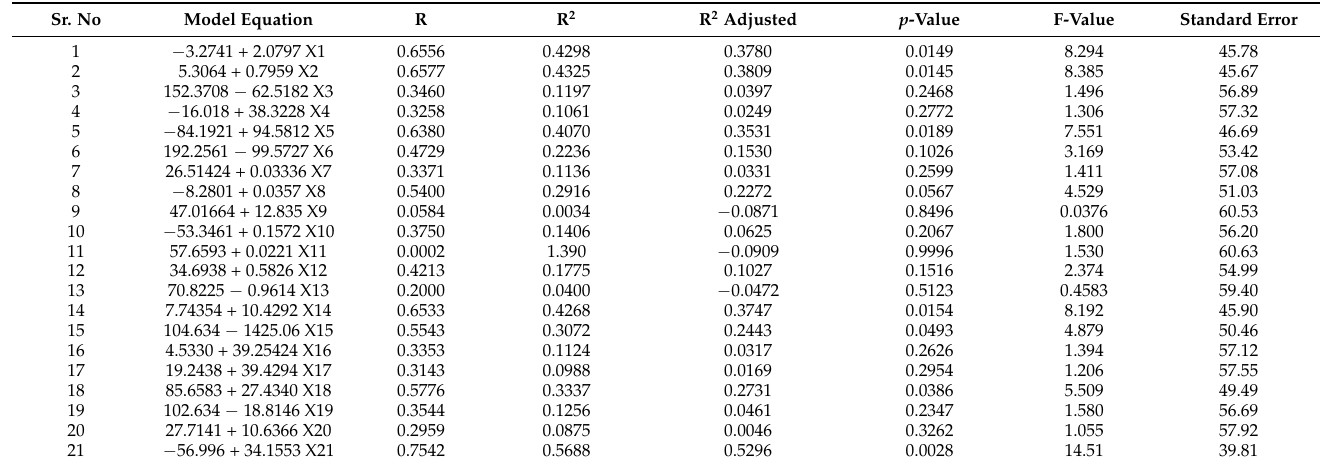
Table 3. Linear regression analysis to show the relationship between the Langmuir constant (Q) for Aerva javanica and metal ionic